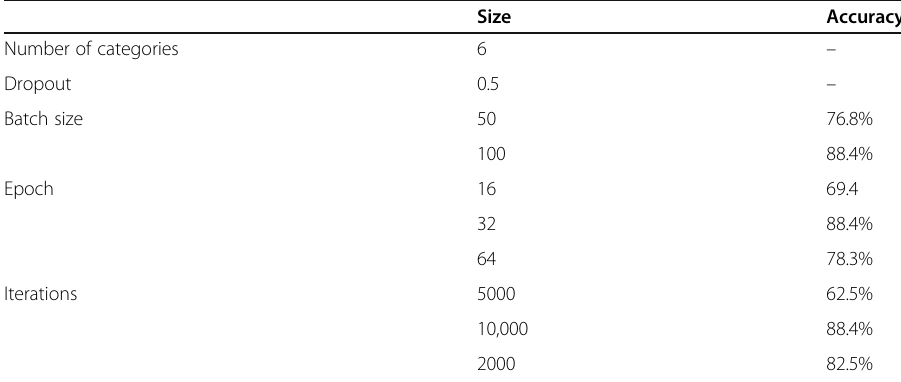
Table 4 Comparison outcomes for different parameter values Size Accuracy Number of categories 6